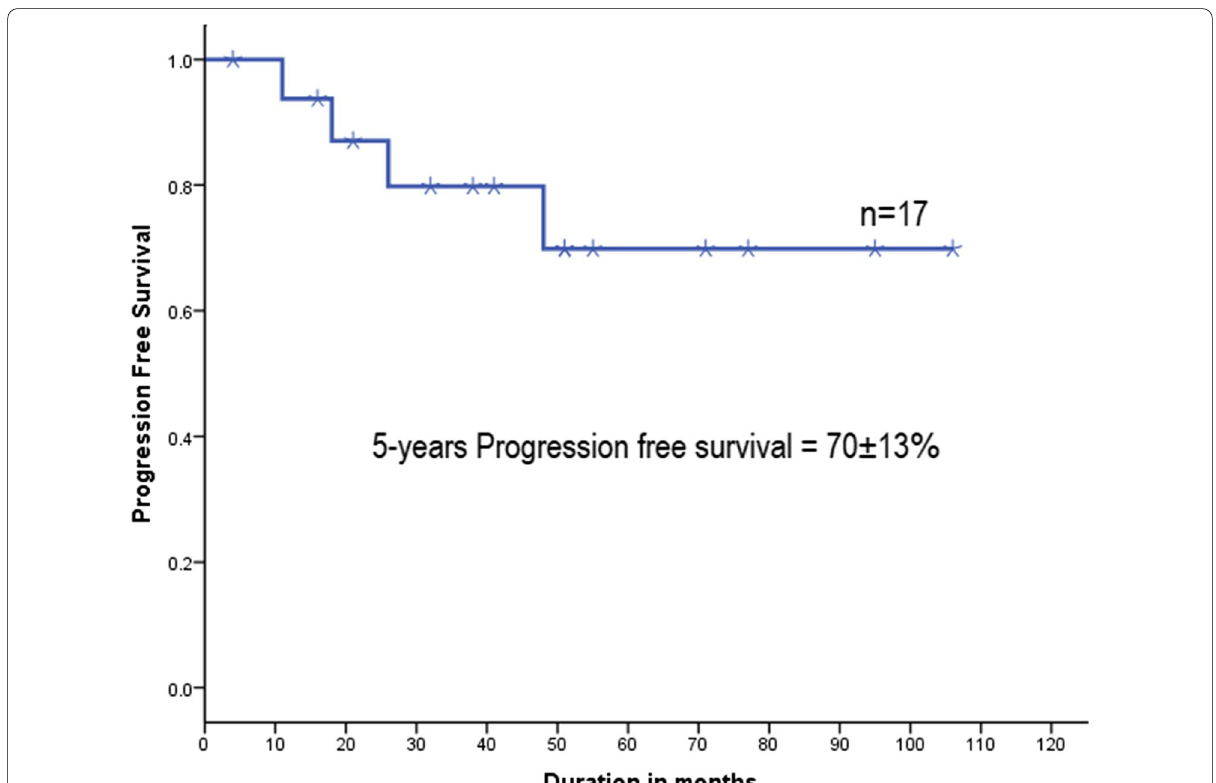
Fig. 3 Progression free survival. The curve showed the progression‑free